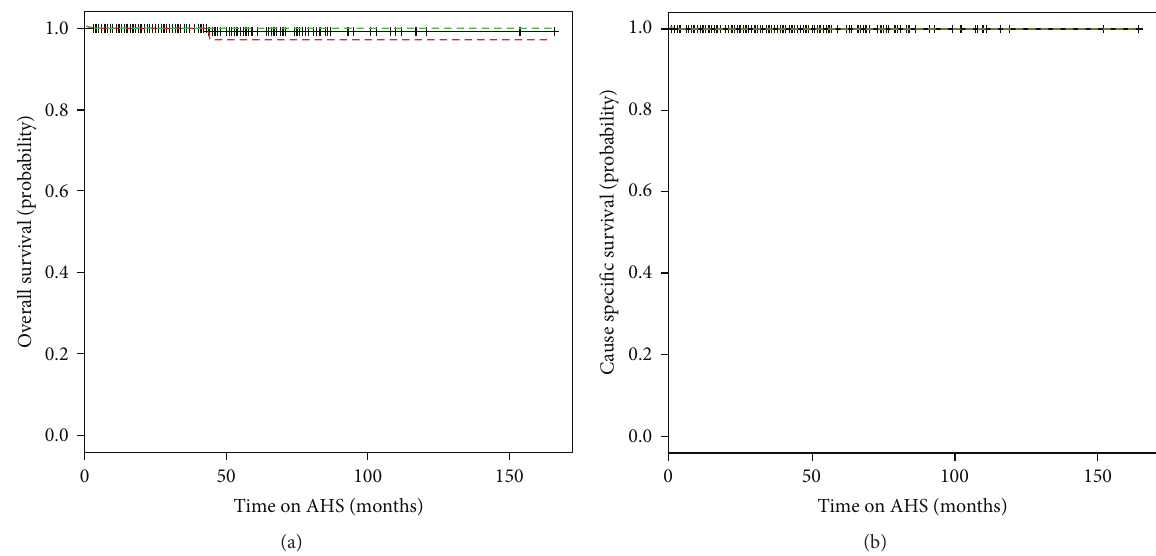
Figure 2: Kaplan-Meier survival curves. (a) The overall survival of the AHS cohort. (b) The disease specific survival of the AHS cohort (key: solid black line represents the probability; red and green lines represent the standard deviation of the curve).